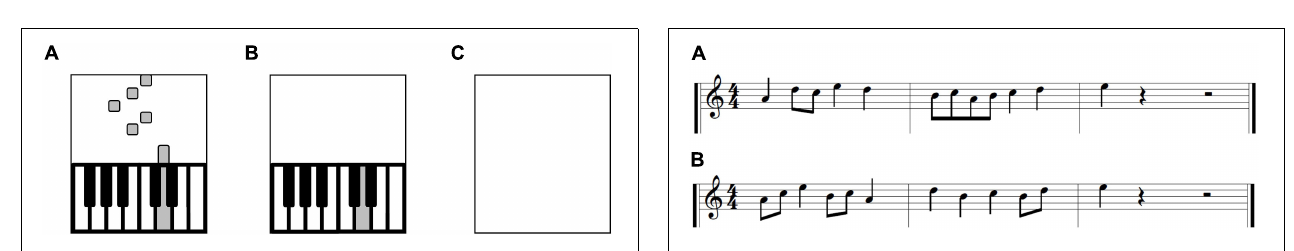
FIGURE 4 | Piano melodies. (A) Melody 1. (B) Melody